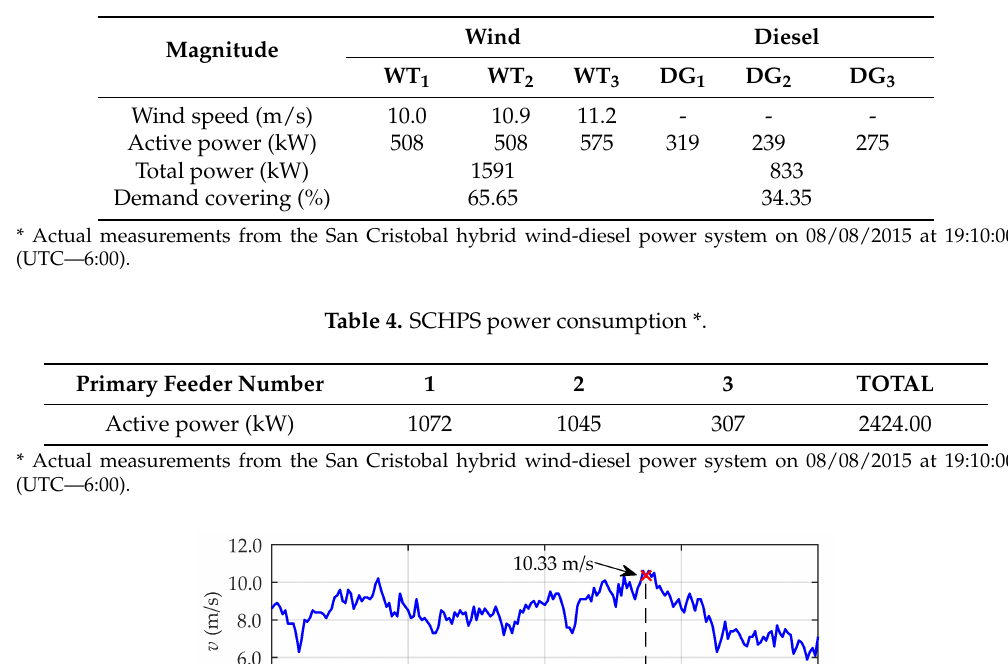
Table 3. SCHPS power production *.